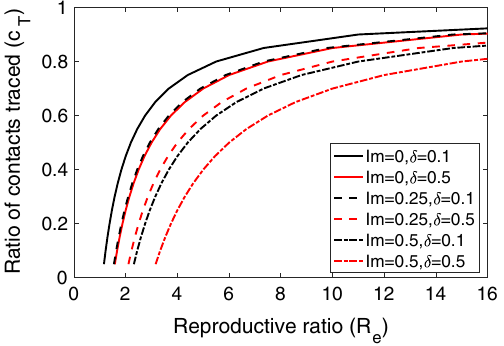
Figure 6. Digital contact tracing thresholds for controlling an outbreak based on Eq. (4), considering different values of the ratio of immunised individuals (Im) and detection rate ( δ ). The pair of values above the lines results in a disease-free